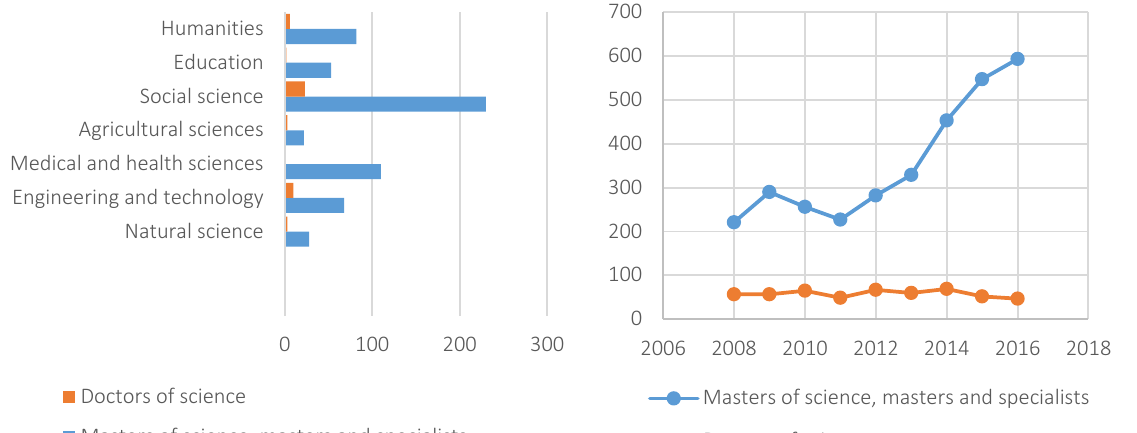
Figure 8. Masters of science, masters, specialists and doctors of science according to the scientific area (2016) and for the period